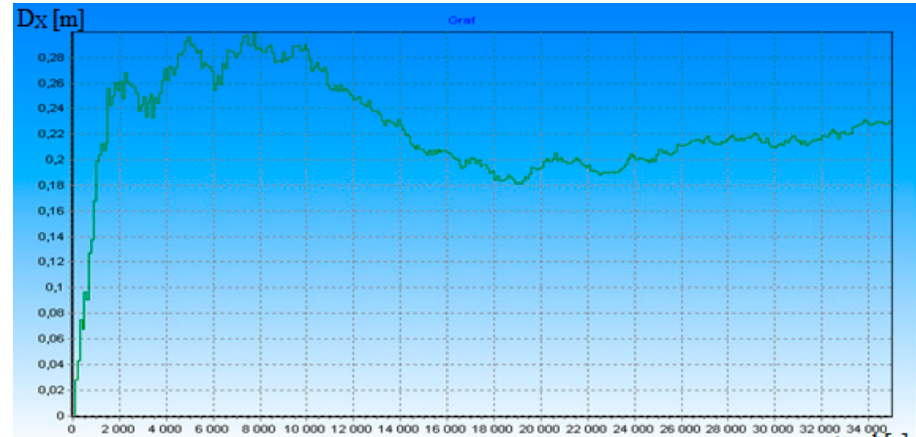
Figure 7. Measurement distance dependence error D X on time t for ρ = 2.